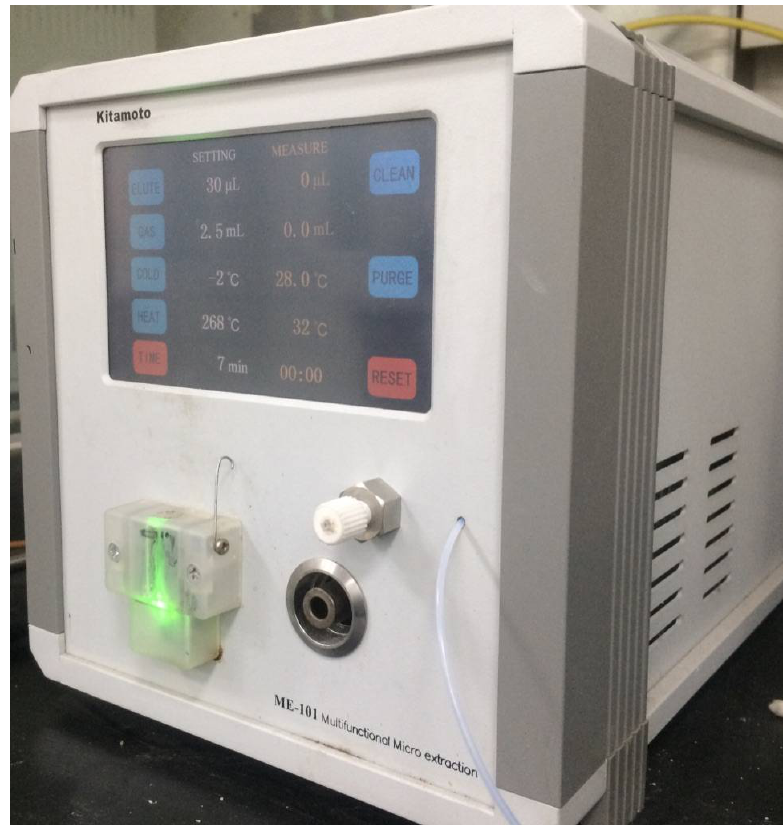
Figure 7. Gas-liquid